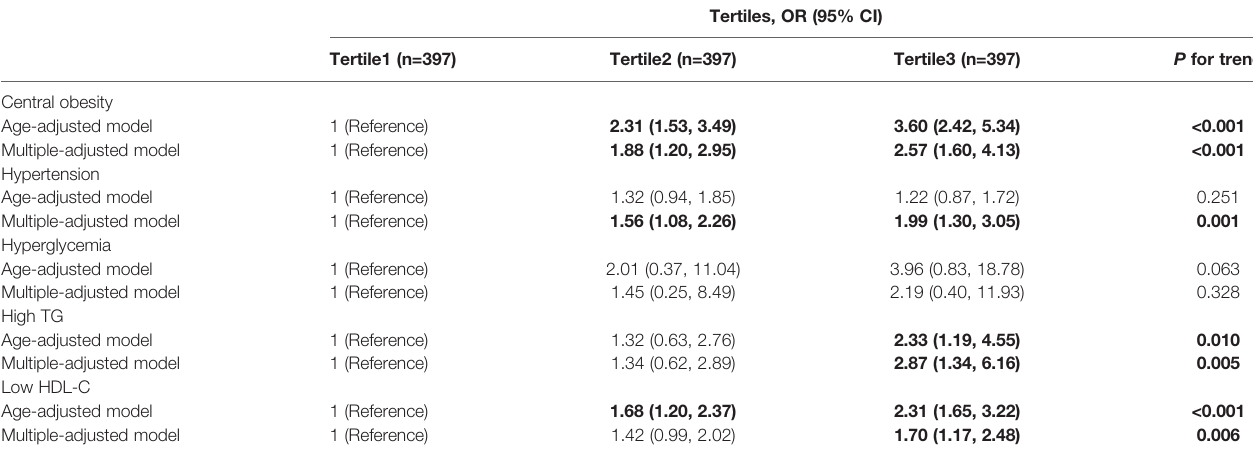
TABLE 4 | Multivariable adjusted odds ratios and 95% con fi dence interval (CI) for metabolic syndrome (MetS) components across C1q tertiles.